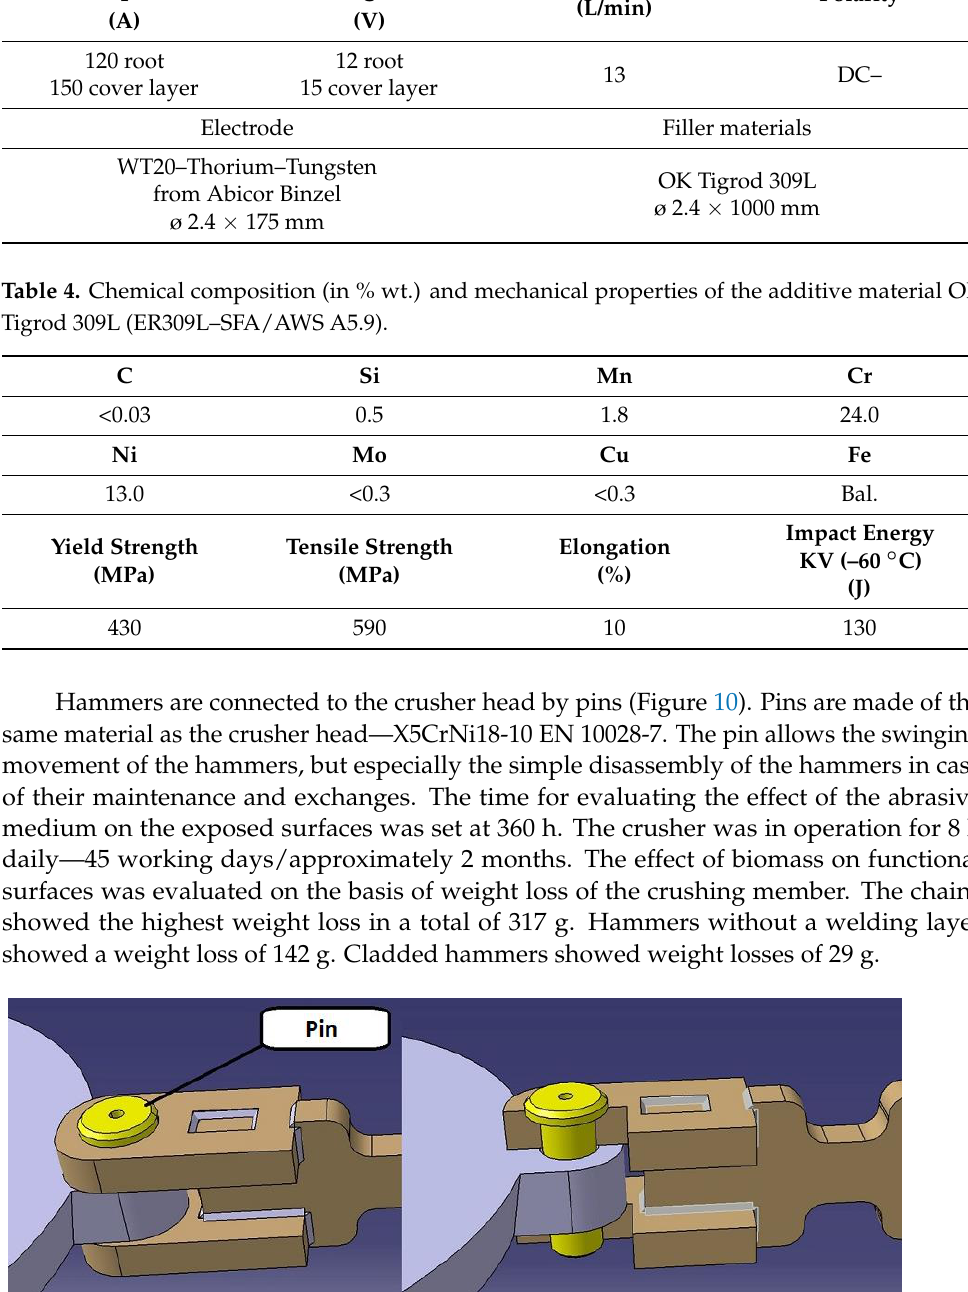
tion to extending the service life by exchanging the chains for hammers, the renovation of worn functional surfaces of hammers by arc welding, which was not feasible when using